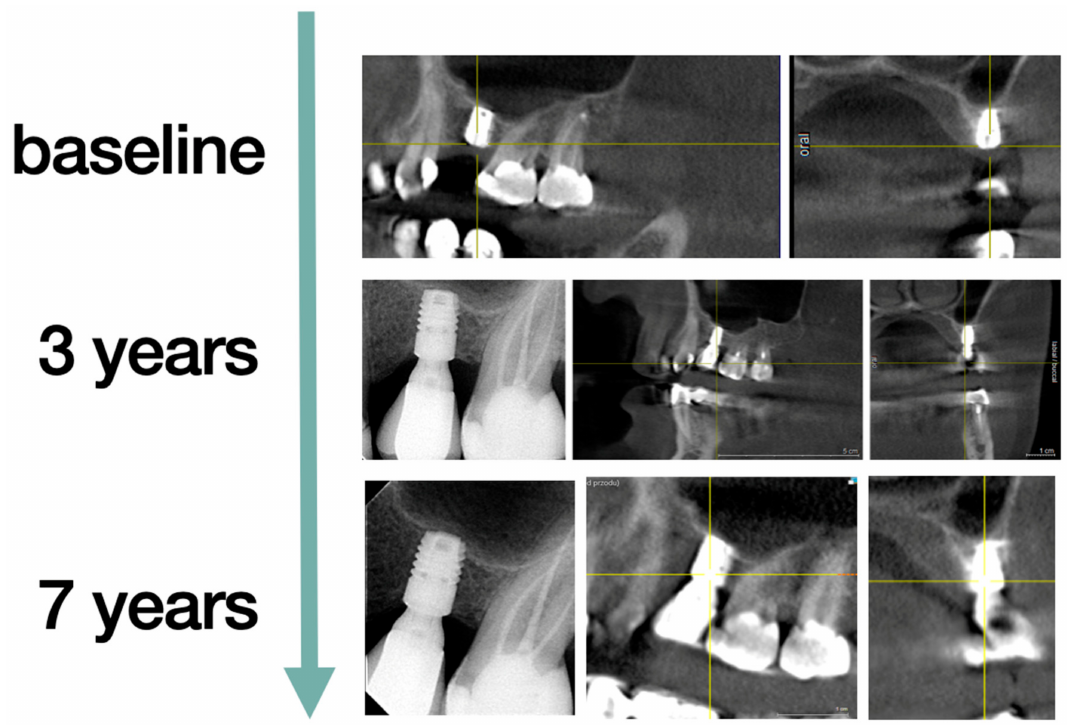
Figure 2. Short implants. The same patient from baseline to seven years, implant tooth 26, follow-up. Periapical X-ray and Cone Beam Computed Tomography (CBCT) are presented.